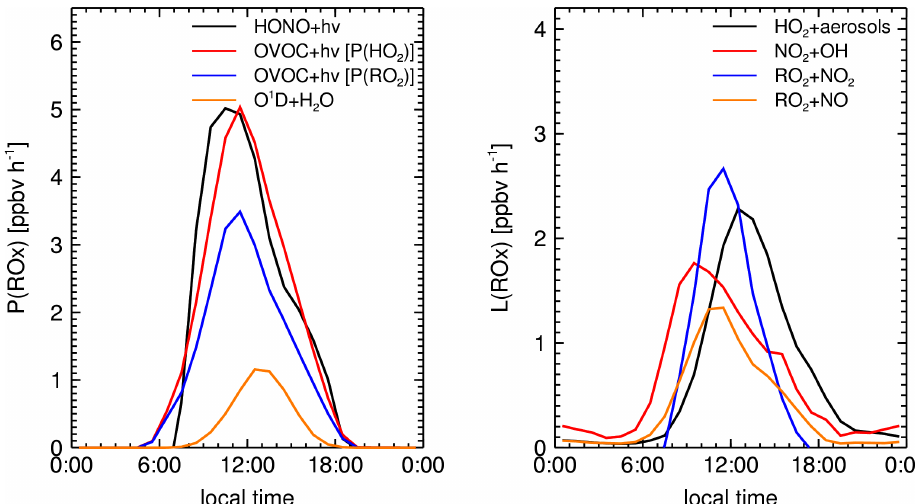
Fig. 3. Average diurnal profiles of major RO x primary sources and